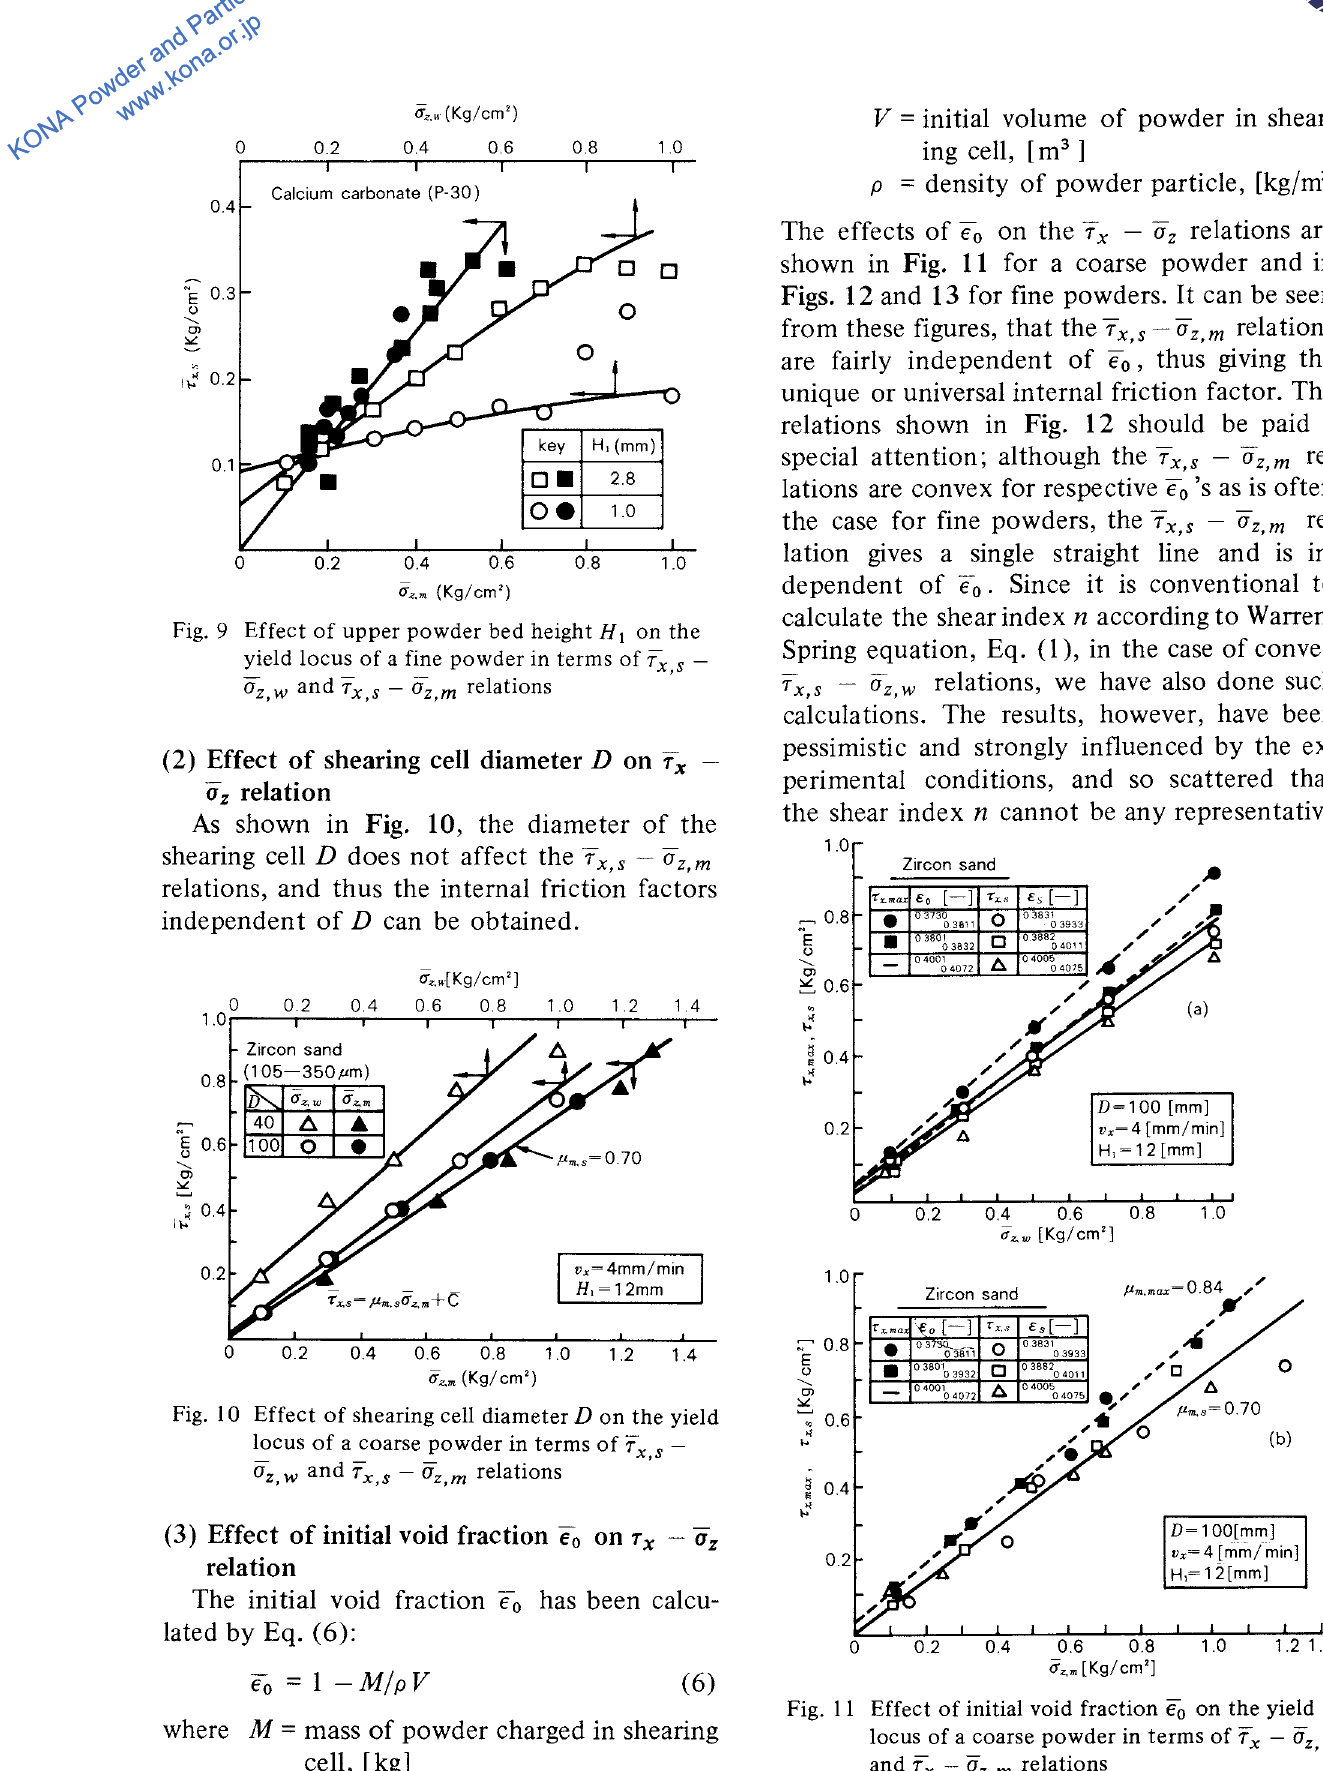
Effect of shearing cell diameter D on the yield locus of a coarse powder in terms of 7 - - - x,s Oz, w and 7 x,s - Oz,m relations